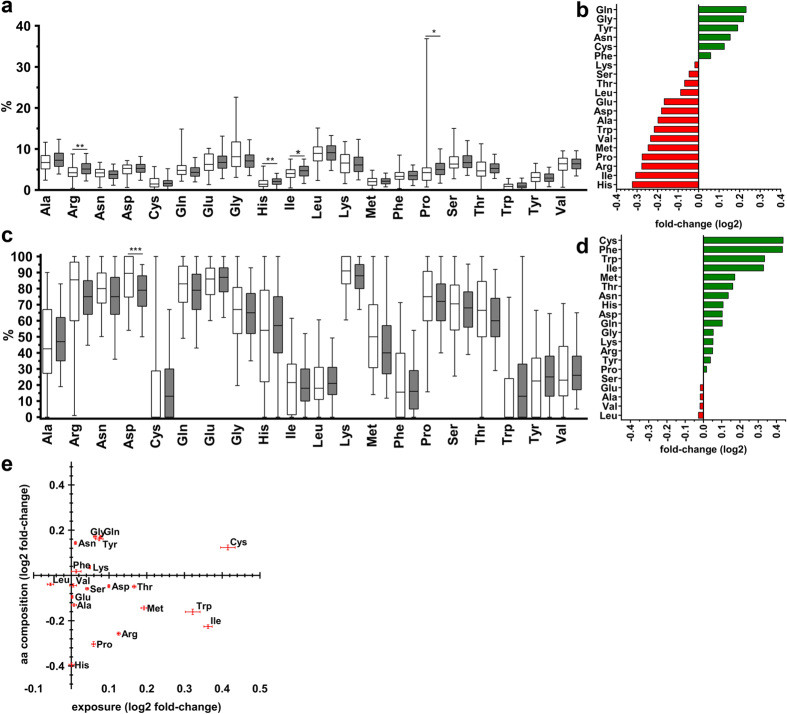
Observed amino acid frequency and predicted solvent molecular surface exposure of amino acids.(a) Four amino acids (Arg, His, Ile, Pro) were significantly more or less expressed in the pellicle (white) than in the saliva (grey). (b) Mean fold-changes (log2) of amino acid expression in the pellicle compared with saliva. Proteins of the pellicle included Gln, Gly, Tyr, Asn, Cys and Phe more often than salivary proteins, whereas expression frequency of all other amino acids was lower in pellicle than salivary proteins. (c) Summary of predicted amino acid exposure in proteins of the pellicle (white) and the saliva (grey). A significant difference was found for Asp only. (d) Predicted exposure of amino acids was higher in the pellicle than salivary proteins for all but five amino acids (Ser, Glu, Ala, Val, Leu). (e) Combined results (mean ± 95% CI [log2]) did not reveal a single amino acid which was both differently expressed and differently exposed. Mann-Whitney-U test was applied for statistical comparison: *p < 0.01, **p < 0.001, ***p < 0.0001; aa  =  amino acid.